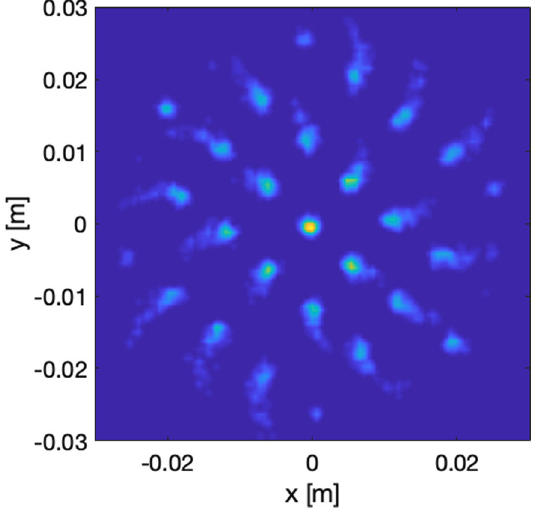
FIG. 5. Simulated viewer image of 5 superimposed vertical measurements.